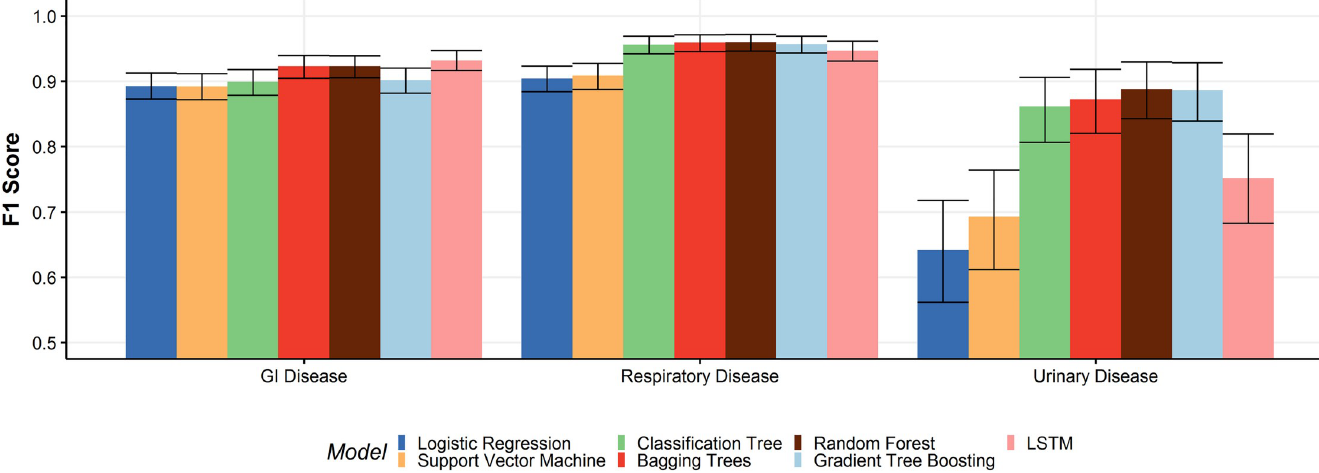
Fig 7. Comparison of F1 scores for all models. F1 scores were calculated using 10-fold cross-validation and bootstrapping to produce 95% confidence intervals (error bars).